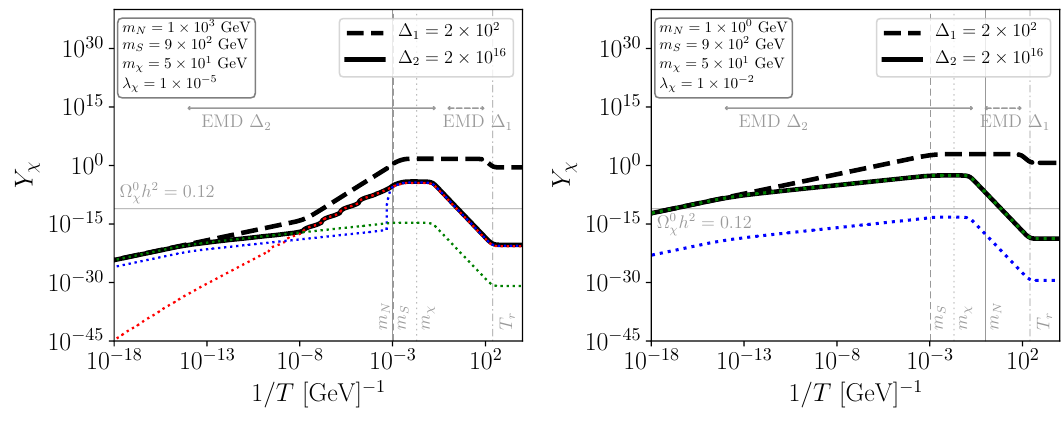
Figure 4 . Evolution of the yield of (cid:31) in the case of small and large entropy production (dashed and solid curves respectively). In the left (right) panel we have m N > m (cid:31) ; m S ( m N < m (cid:31) ; m S ). For larger entropy production ((cid:1) = 2 10 16 ), contributions from decay (dotted red), s-channels (cid:2) (dotted blue) and t-channels (dotted green) are also